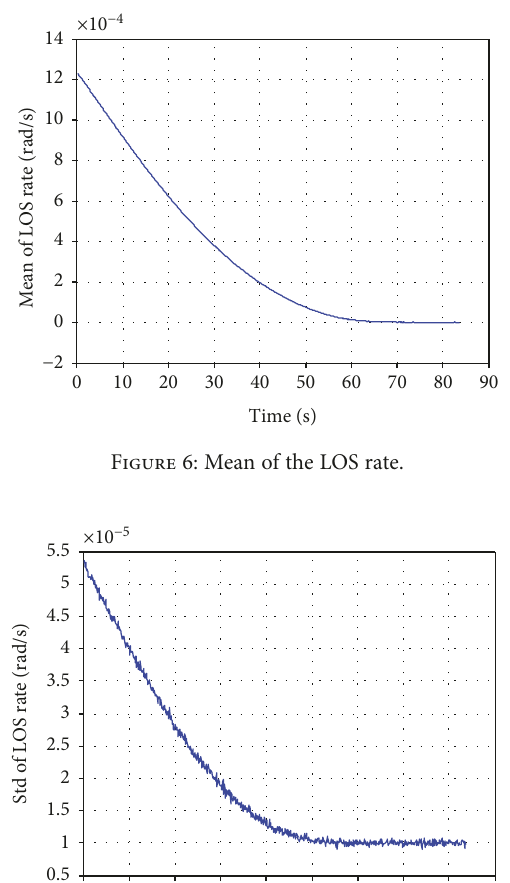
Figure 10: Skewness of the LOS rate (10 times of initial position